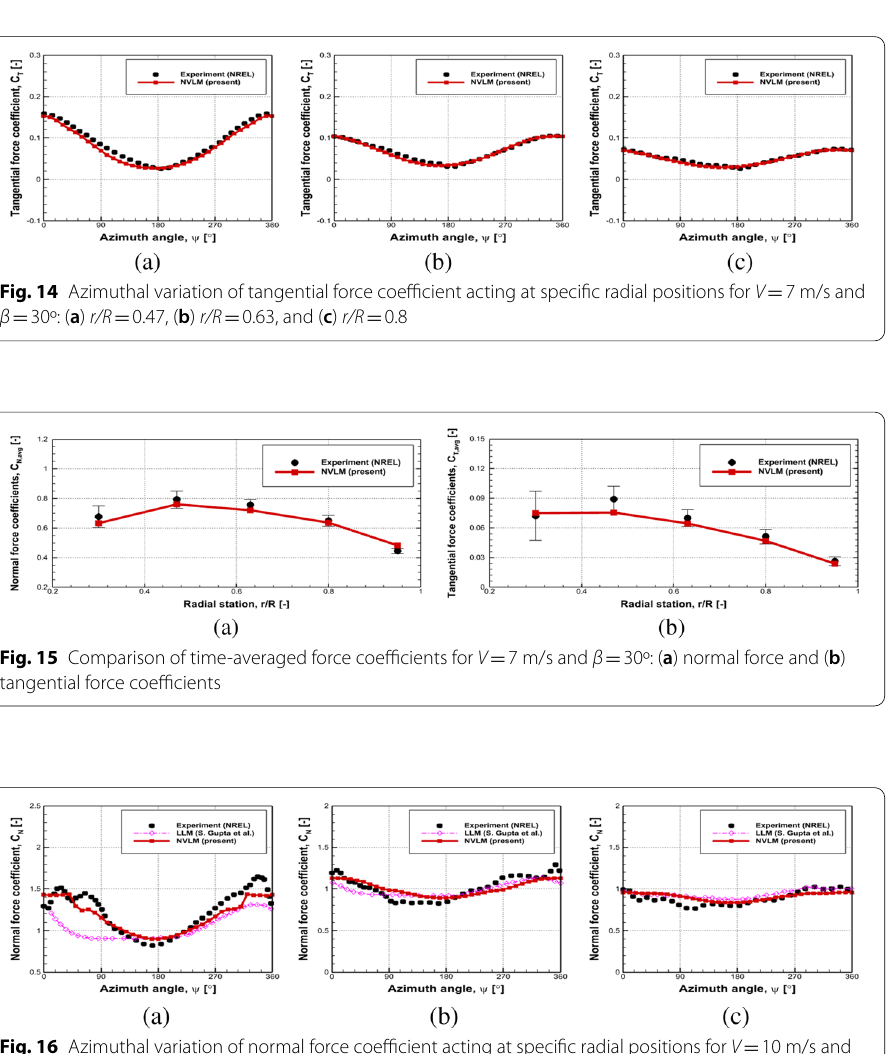
Fig. 16 Azimuthal variation of normal force coefficient acting at specific radial positions for V β 30º: ( a ) r/R 0.47, ( b ) r/R 0.63, and ( c ) r/R = = =